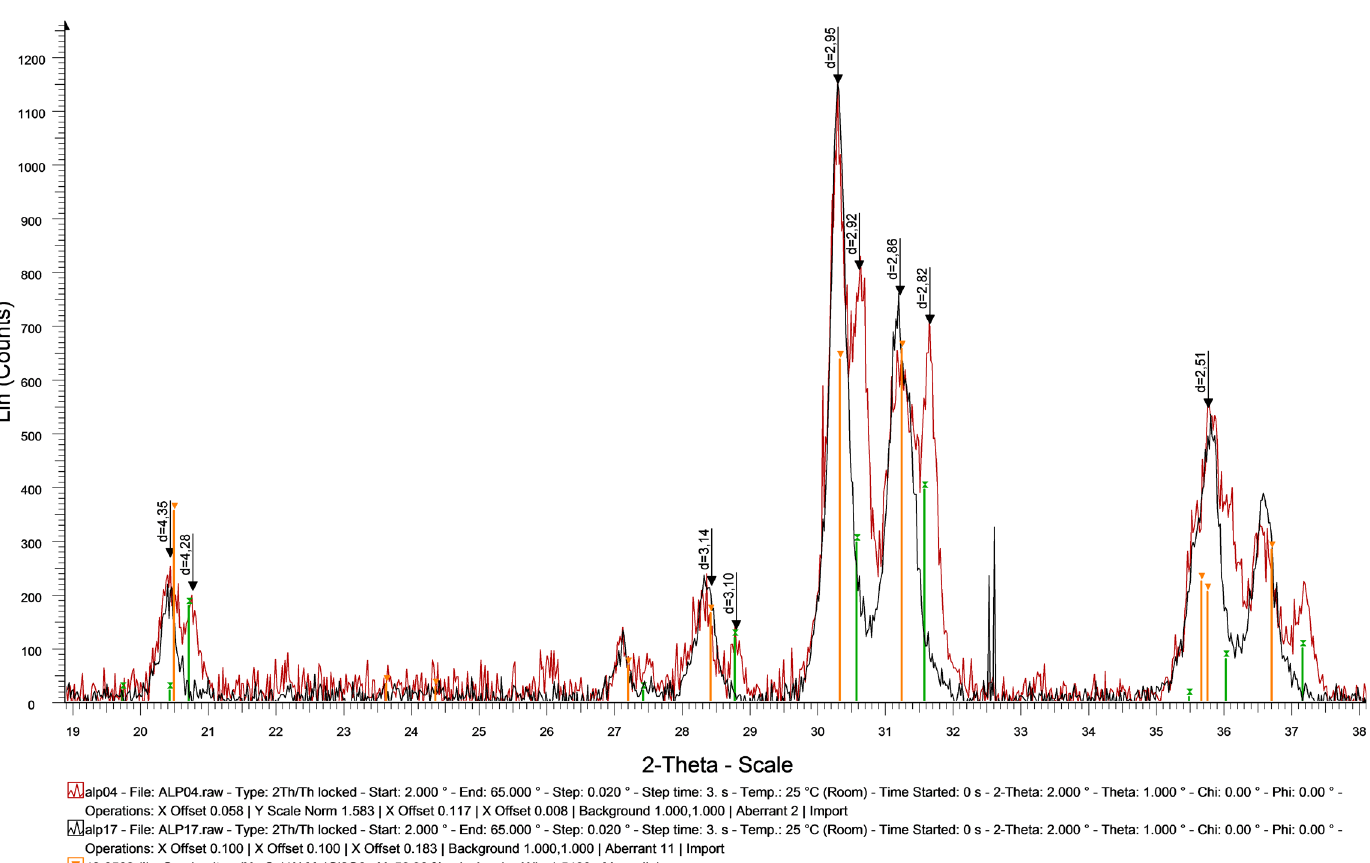
Figure 9. Example of a diffractogram (zoom between 20 and 40 2θ) of some Alpine samples as examples of various Na -Px compositions. Alp04 (red) and Alp17 (black) samples (superimposed). Orange bars: peaks corresponding to omphacite; red bars: peaks corresponding to jadeite. Alp17 does not show traces of jadeite. Produced by O. Lantes from DIFFRACplus EVA software ©